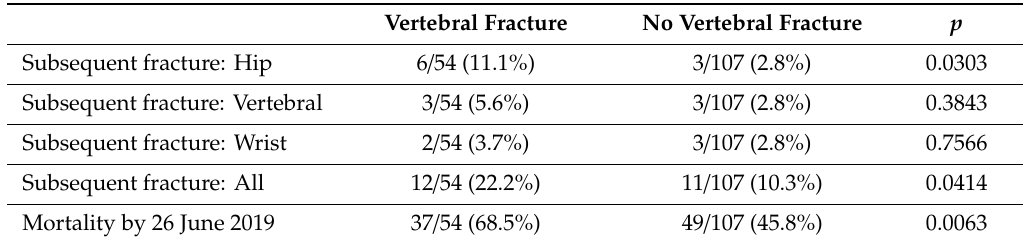
Table 2. Subsequent fractures and mortality following